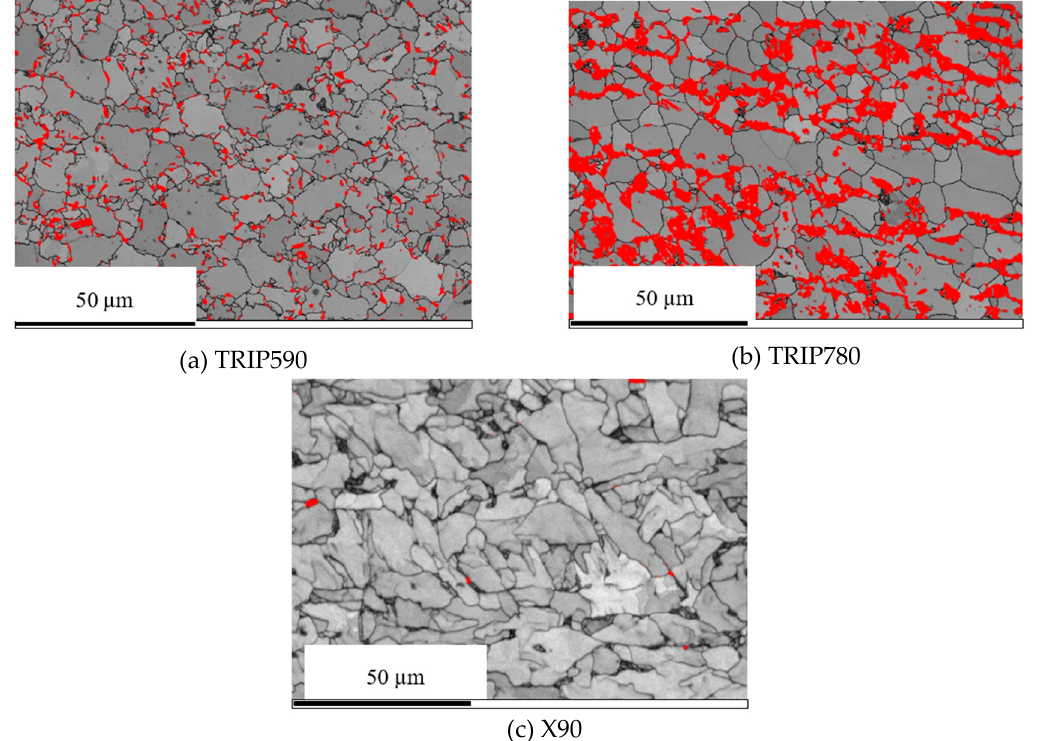
Figure 13. The morphology and distribution of retained austenite in three steels ( a : TRIP590; b : TRIP780; c :